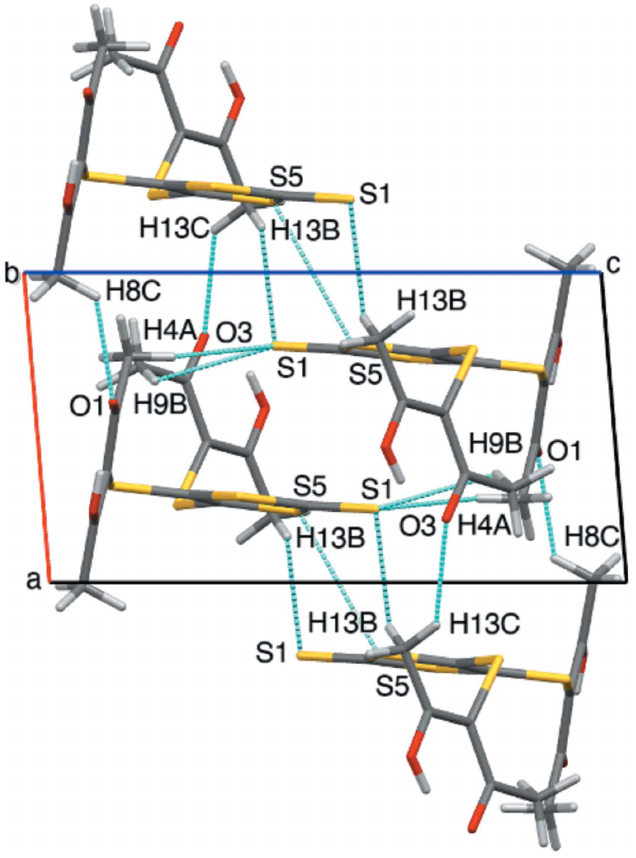
Figure 1 The title compound with displacement ellipsoids drawn at 50% probability level and hydrogen bonds (O—H (cid:4)(cid:4)(cid:4) O) in the asymmetric unit